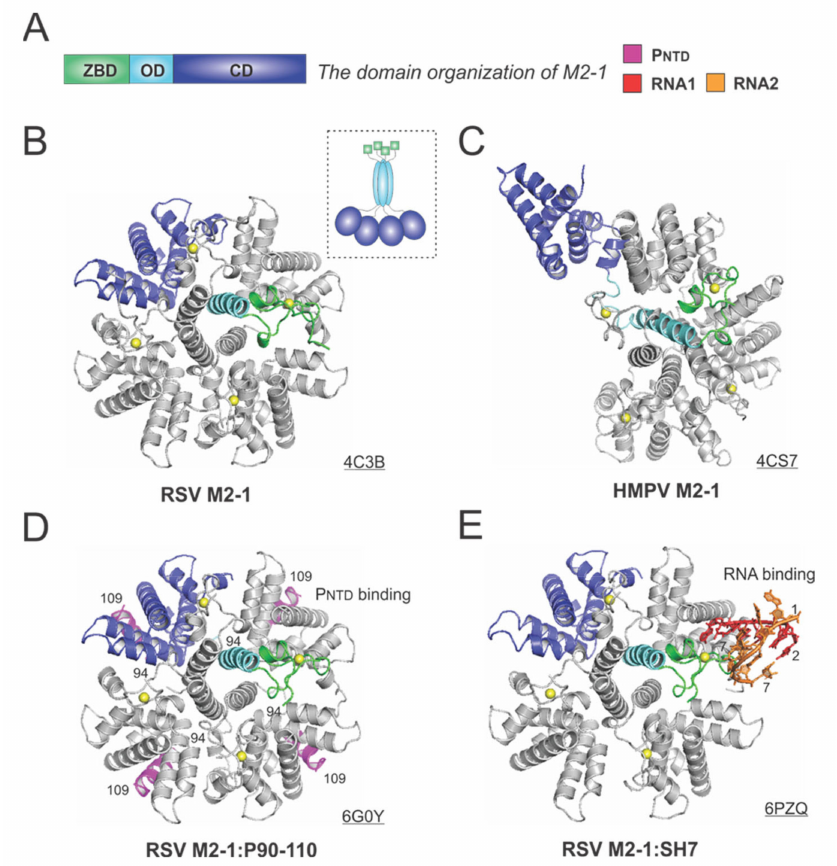
Figure 6. The structures of the M2-1 protein from RSV and HMPV. ( A ) The linear domain organi- zation of the M2-1 protein. There are three domains: the zinc-binding domain (ZBD, green), an oligomerization domain (OD, cyan), and a core domain (CD, blue). ( B ) The crystal structure of the RSV M2-1 (PDB: 4C3B). The cartoon representation of the RSV M2-1 is shown in the dotted box. ( C ) The crystal structure of the HMPV M2-1 (PDB: 4CS7). Note that the protomer in the open state is shown as the same color scheme as in panel A. ( D ) The crystal structure of the RSV M2-1 in the complex of the P NTD (PDB: 6G0Y). The P NTD is highlighted in magenta, consistent with Figure 4. ( E ) The crystal structure of the RSV M2-1 in the complex of a short RNA oligo (PDB: 6PZQ). Two RNA molecules are colored in red and orange, respectively. Four protomers are shown in the M2-1 structures. Only one protomer is colored as the domain organization, and the rest are in gray. The PDB accession codes are